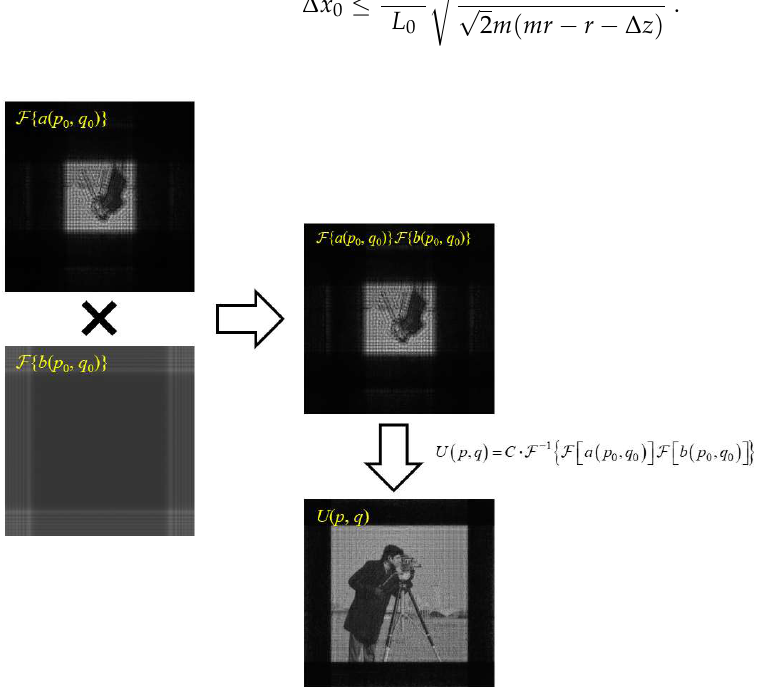
Figure 2. Schematic of sampling condition analysis process of SFD with amplitude distributions of some factors involved.